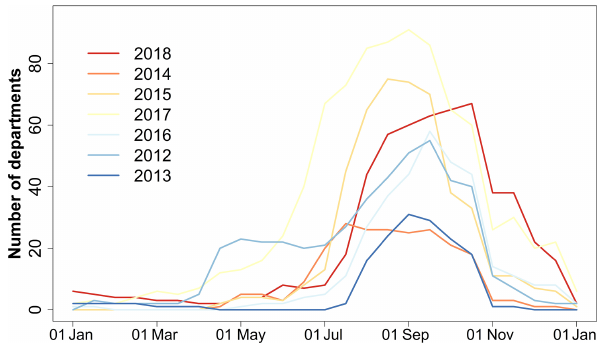
Figure 15. Number of departments with at least one sub-catchment with WRL ≥ 1. The colour of the curves is associated to the annu- ally averaged air temperature rank for France – from red to blue for the warmest (2018) to the coldest (2013) year – (sources: Météo- France and French ministry of